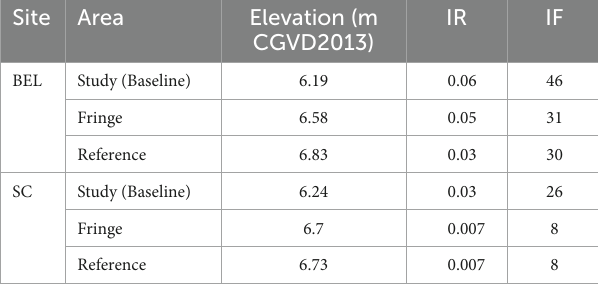
TABLE 1 Mean elevation, IR, and IF for BEL and SC for baseline conditions